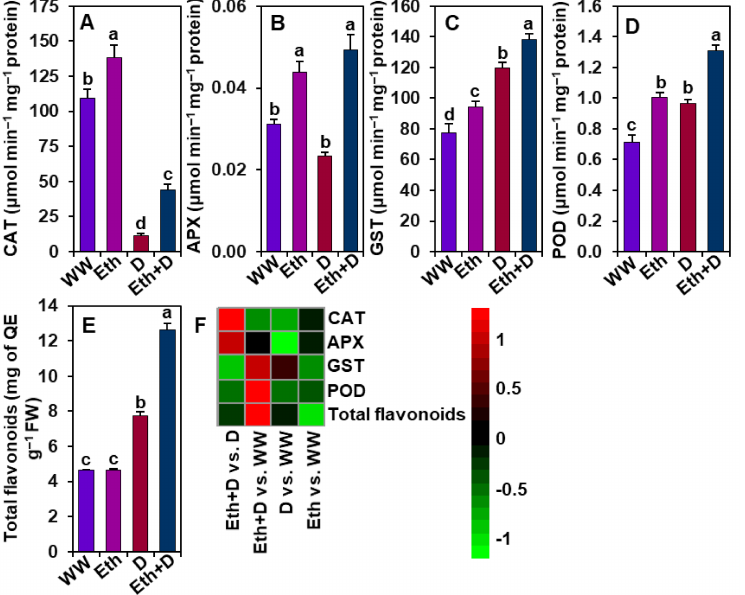
Figure 5. Effect of exogenously supplied 20-mM ethanol on antioxidant defense responses in the leaves of soybean plants subjected to drought stress for a period of 8 days. Activities of ( A ) CAT (catalase), ( B ) APX (ascorbate peroxidase), ( C ) GST (glutathione S -transferase), and ( D ) POD (peroxi- dase) and the content of ( E ) total flavonoids in soybean leaves under different treatment conditions. ( F ) Heatmap of the fold-change values of the aforementioned parameters in soybean plants under different treatments. Bars represent means with standard errors ( n = 4). Different letters shown above the bars are used to indicate significant differences among the treatments ( p < 0.05). WW, Eth, D, and Eth + D indicate water-sprayed well-watered plants, ethanol-sprayed well-watered plants, water-sprayed drought-exposed plants, and ethanol-sprayed drought-exposed plants, respectively. FW, fresh weight; QE, quercetin